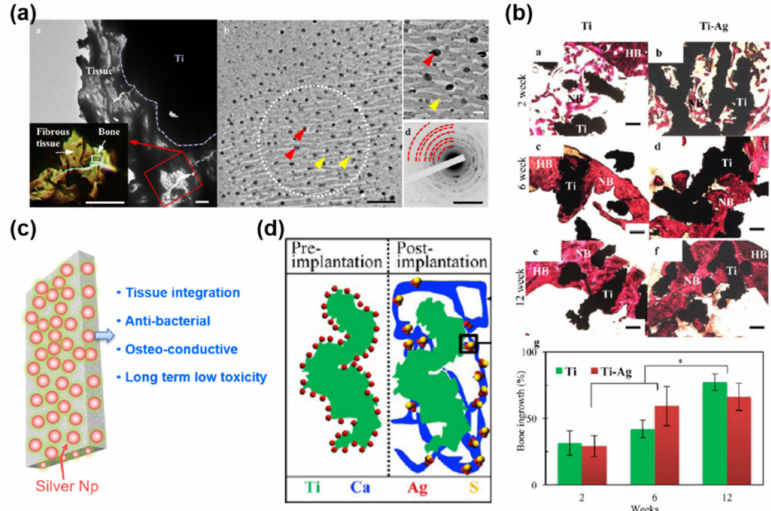
Figure 3. ( a ) Ti-based bioimplant–tissue integration promoted by Ag nanoparticles; ( b ) H&E staining at 2, 6, and 12 weeks of implantation showing enhanced bone growth around the bioimplant. ( c ) Controlled release of Ag-nanoparticle (Ag NPs) from Ti surface causing enhanced tissue integration, anti-bacterial e ff ect, osteoconductivity, and long-term low toxicity; ( d ) Schematic showing AgNPs acting as focal point of tissue adhesion and bone growth through interaction with calcium that regulates the biological responses [115]. Adapted with permission from [115]; 2017 American Chemical